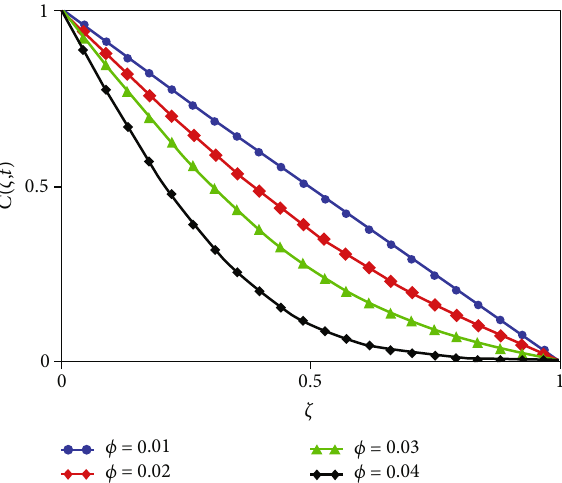
Figure 11: Impact of ϕ on concentration